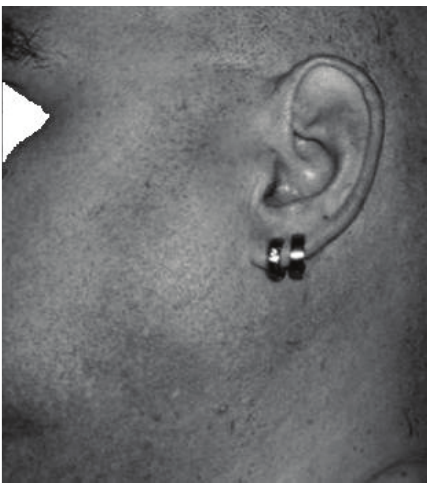
Figure 1: Hypertrophy of masseter muscle. Facial stiffness makes eating